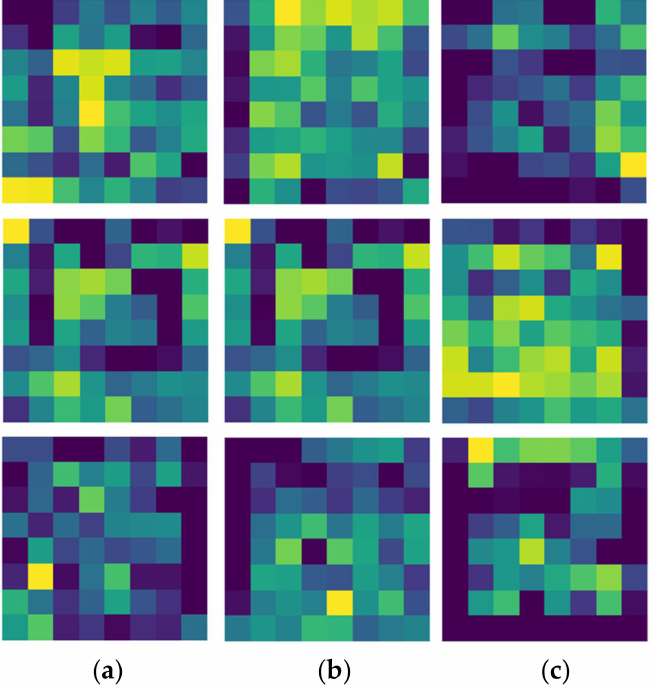
Figure 15. The visualization of the high-dimension feature map of the model proposed in Figure 8: each subfigure for column ( a – c ) comes from a randomly selected